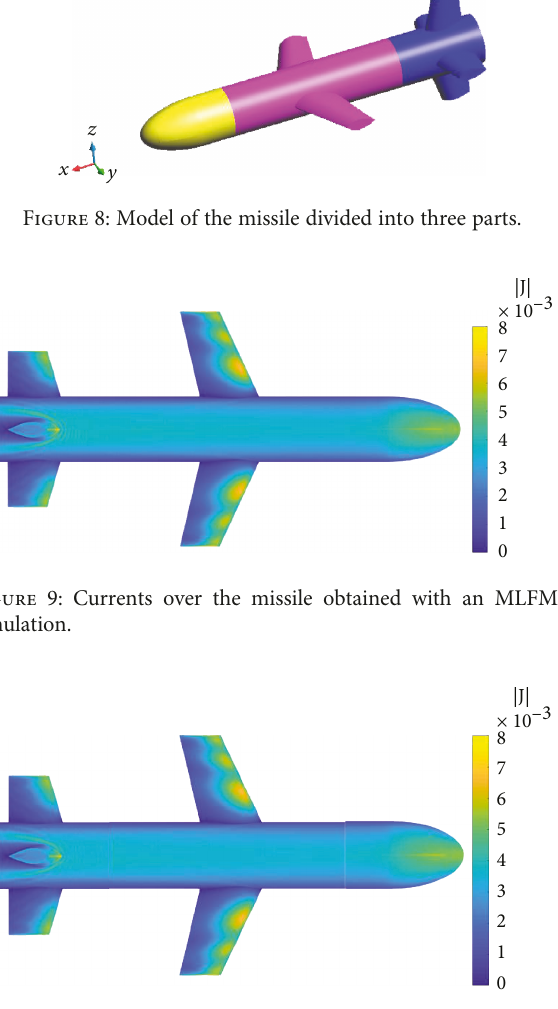
Figure 10: Currents over the missile obtained with an IE-NDDM simulation.